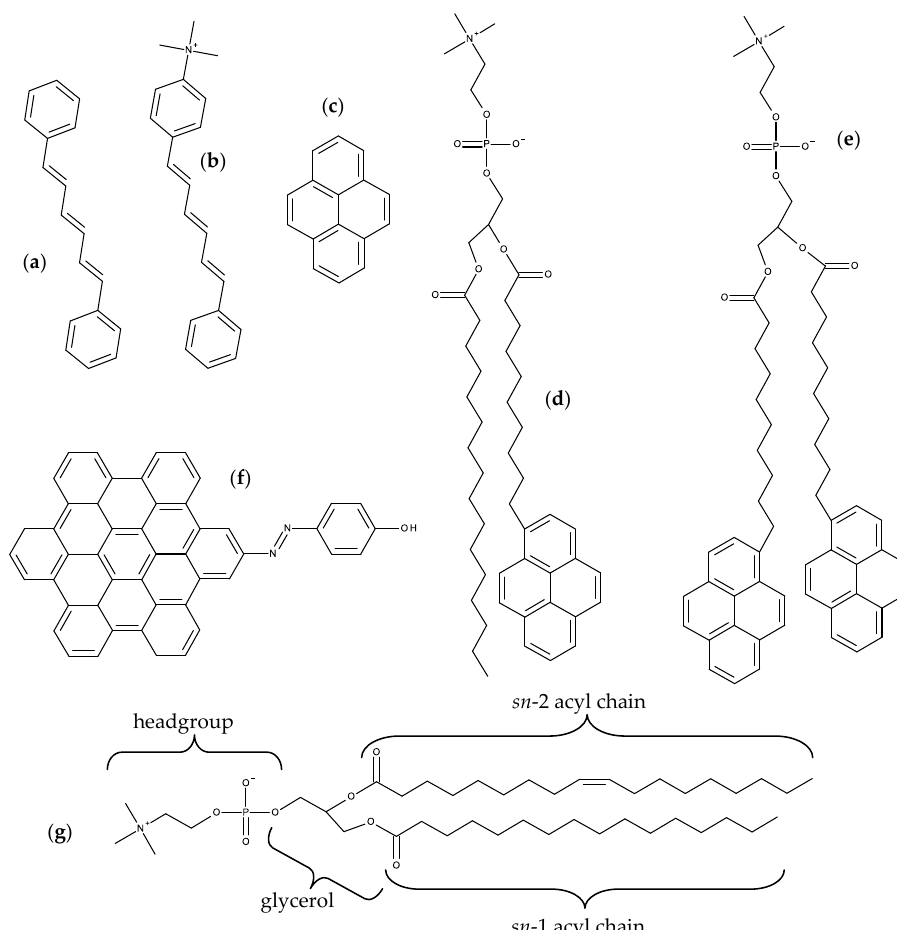
Figure 1. ( a )–( f ) Structures of aromatic hydrocarbon probes. ( a ) DPH; ( b ) TMA-DPH; ( c ) pyrene; ( d ) PYR-PC; ( e ) PYR10; ( f ) HBC-azo. ( g ) Structure of a membrane lipid commonly used in MD simulations (POPC), with indication of different parts of the molecule.